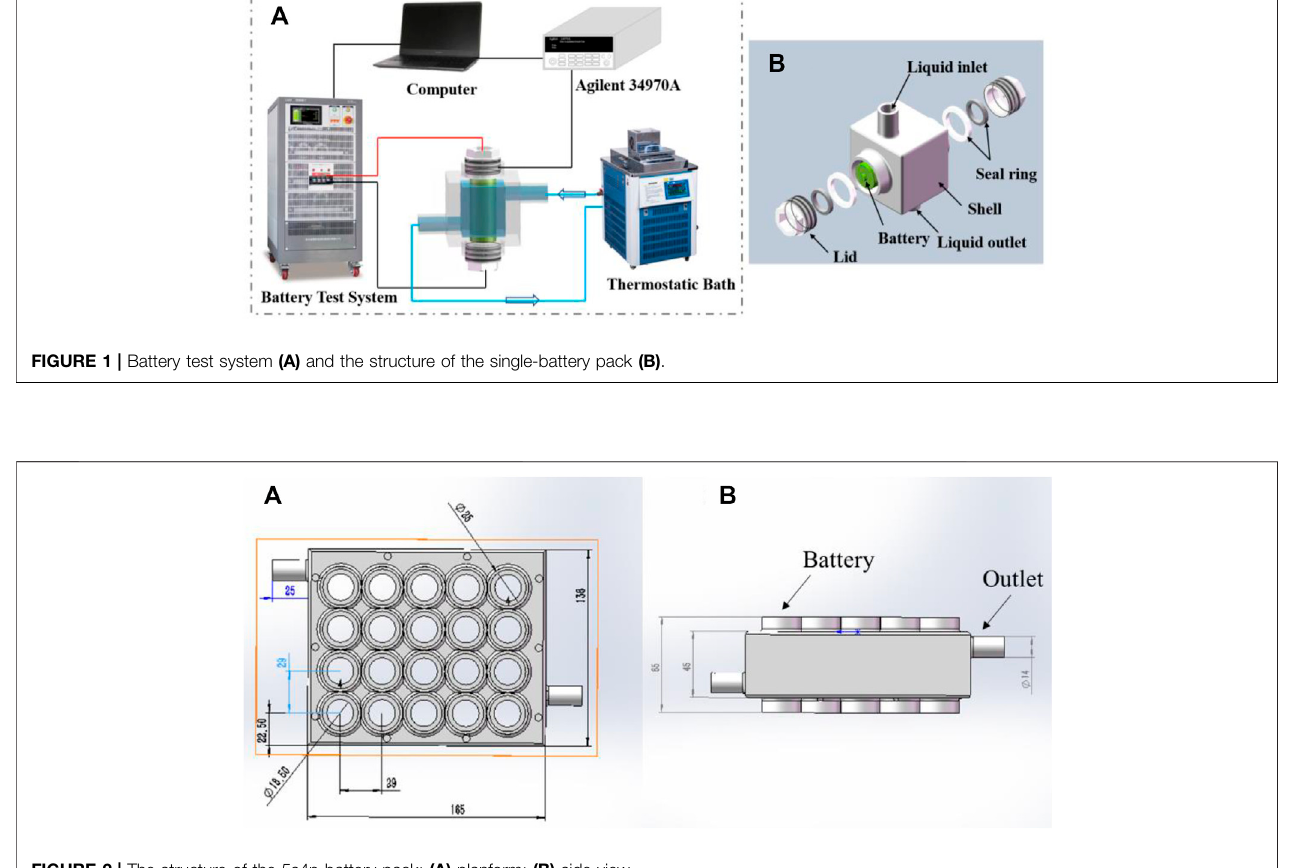
Frontiers in Energy Research |